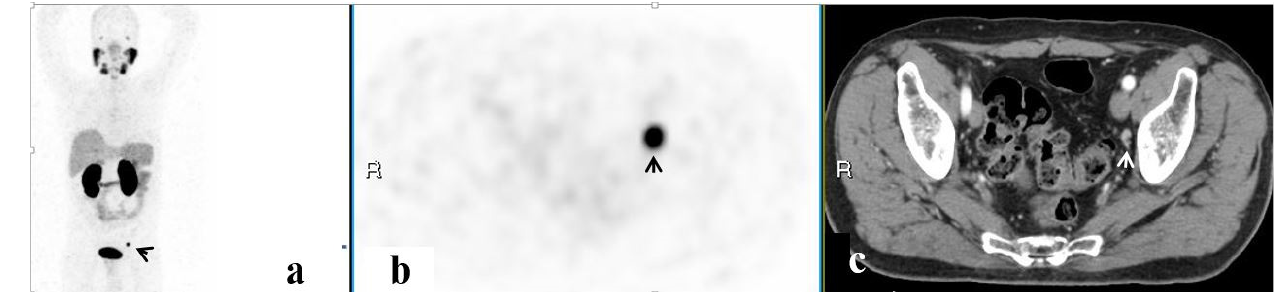
Figure 1. A PSMA-avid lesion in a solitary pelvic lymph node. 68Ga-PSMA scan, maximum intensity projection (MIP) ( a ) corresponding PET ( b ) and CT ( c ) axial slices demonstrating focally increased uptake in the solitary pelvic lymph node on the left (arrows).